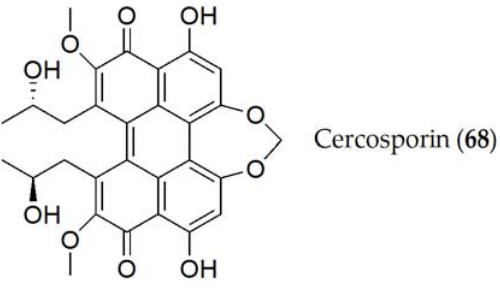
Figure 12. Phytotoxins isolated from Cercospora kikuchii .